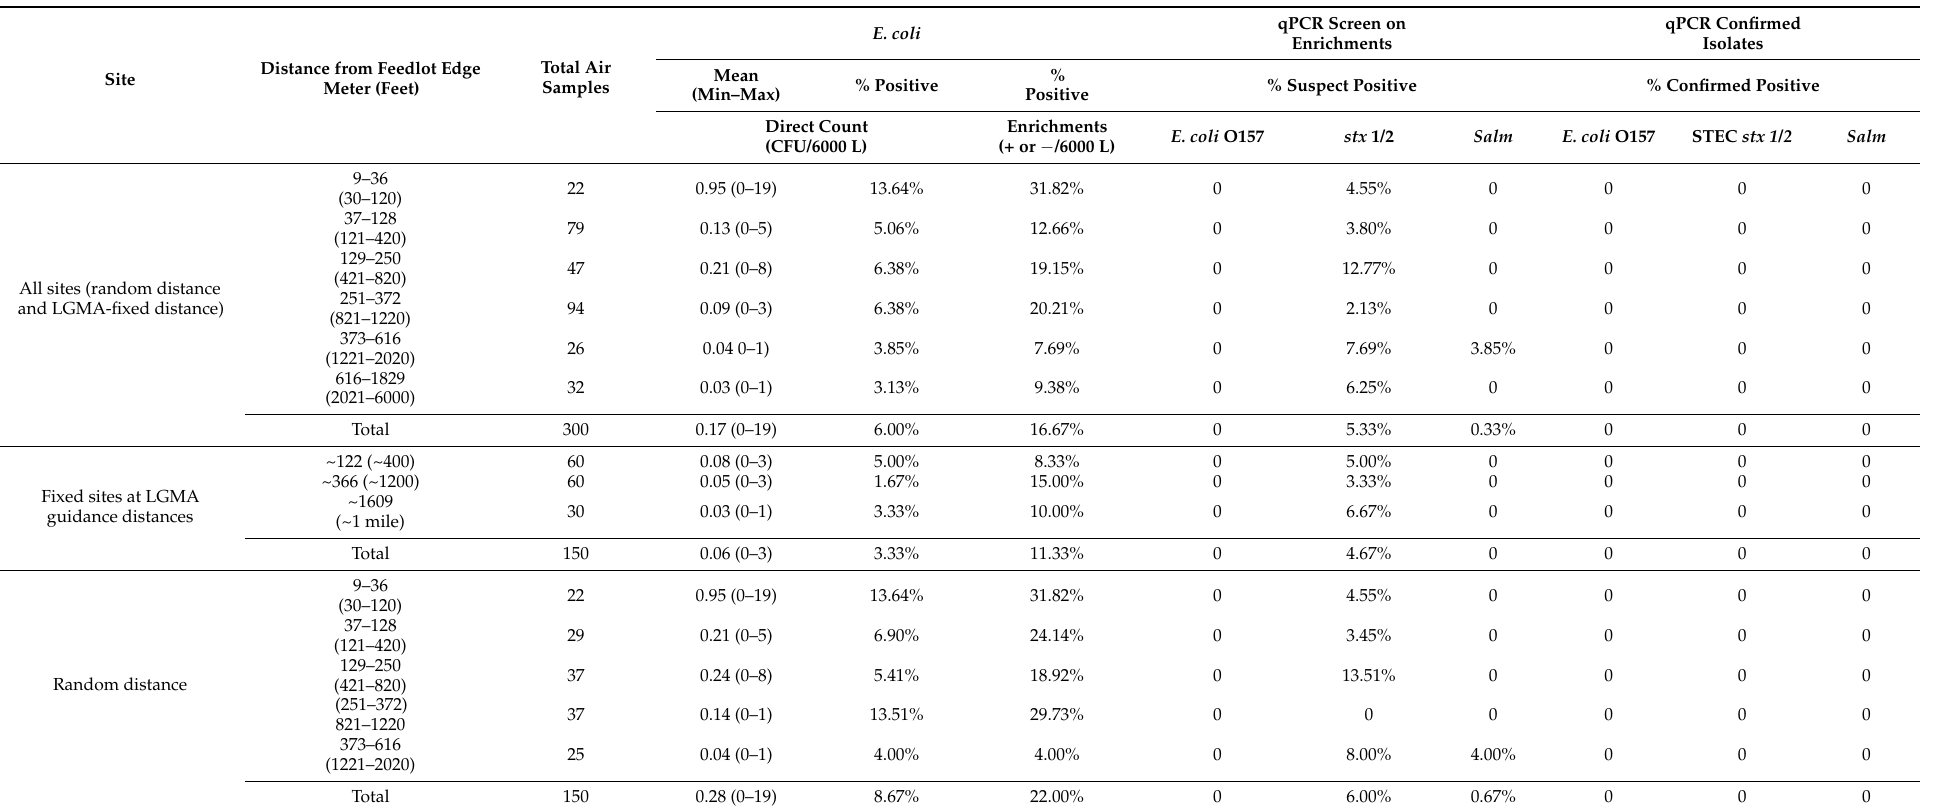
Table 1. Prevalence of indicator E. coli a , E. coli O157 b , non-O157 STEC c , and Salmonella b in 6000-L air samples taken in proximity to five commercial feedlots